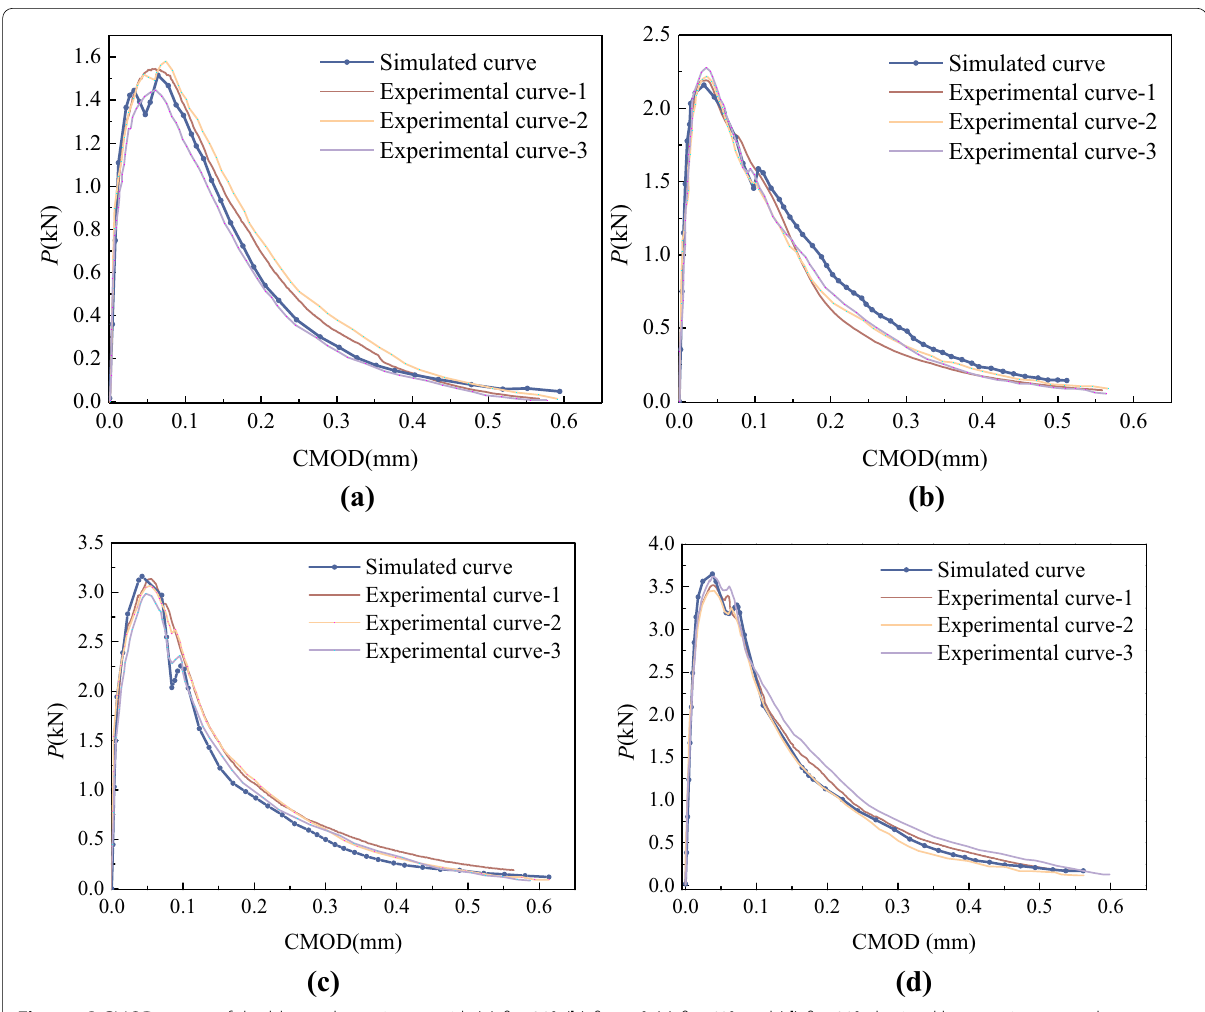
Fig. 17 P ‑CMOD curves of double‑crack specimens with ( a ) θ simulations at the loading rate of 10 –3